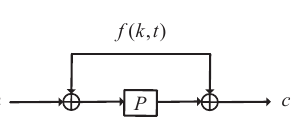
Figure 1: TEM-1: One-round Tweakable Even-Mansour with function f ( k, t ) linear in